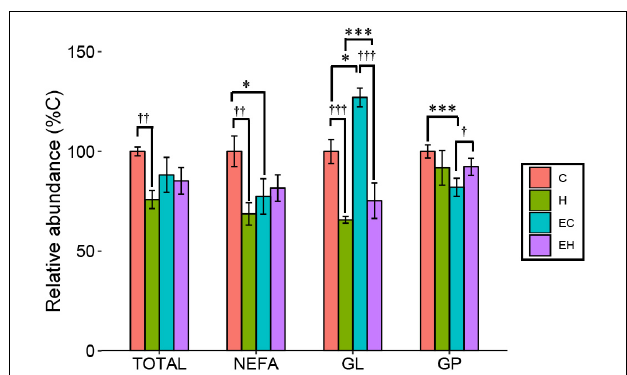
FIGURE 3 | Total content of ω -3 PUFAs and ω -3 PUFA-containing lipid categories affected by endurance training and/or high-fat diet: ∗ p < 0.05 for endurance training effect; ∗∗∗ p < 0.001 for endurance training effect; † p < 0.05 for high-fat diet effect; †† p < 0.01 for high-fat diet effect; ††† p < 0.001 for high-fat diet effect; lines with sticks represent an interaction effect. Data are means ±